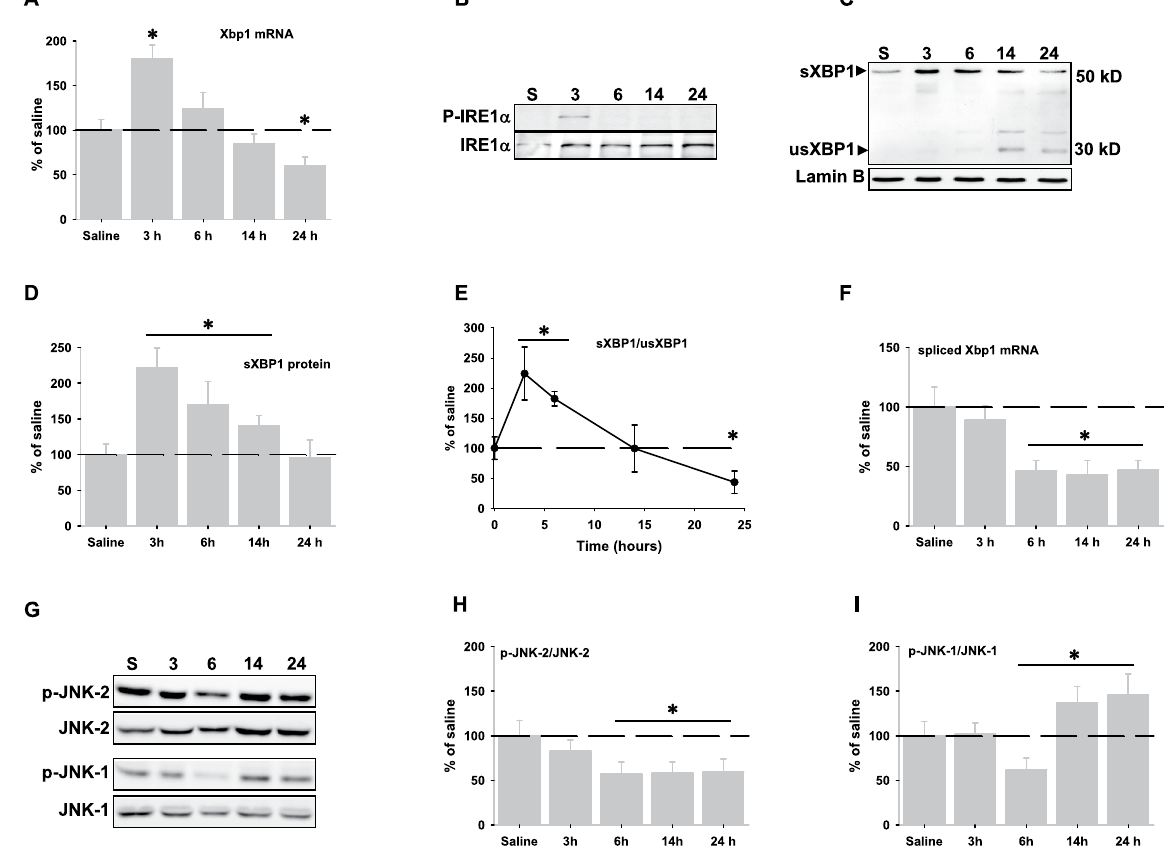
Figure 3. IRE1 α pathway is activated following LPS injection. ( A ) mRNA expression of XBP1 analyzed by RT-real time PCR at different times after LPS injection. ( B ) Representative western blot of the phospho-IRE1 α (P-IRE1 α ) and IRE1 α proteins in the cytosolic fractions at different times after LPS injection. Note the short time expression. ( C ) XBP1 protein expression in the nuclear fractions after LPS injection. The band around 50 kDa corresponds to the spliced active transcription factor (sXBP1), while the other one, around 30 kDa corresponds to the un-spliced (usXBP1) protein. Note the time-dependent increase of the usXBP1 protein. ( D ) Optical density analysis of western blots corresponding to the sXBP1 protein. ( E ) Graphical representation of the sXBP1/usXBP1 protein ratio. ( F ) mRNA expression of spliced XBP1 analyzed by RT-real time PCR. ( G ) Representative western blots of phospho-JNK2 and total JNK2 and phospho-JNK1 and total JNK1 in the cytosolic fractions at different times after LPS injection. Note both JNK1 and 2 inactivation at six hours after LPS injection. ( H and I ) Graphical representation of the phospho-JNK1/JNK1 and phospho-JNK2/JNK2 ratios, respectively determined by optical density analysis. Data are presented as mean ± SD (n = 4) of percentage of variation relative to controls. * p < 0.05, significant differences compared with control (saline-injected)